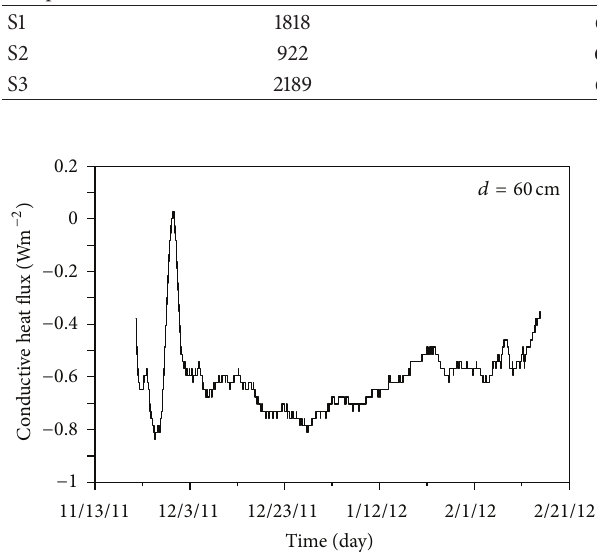
Figure 5: Heat flux estimated by the finite-difference approximation for 60 cm depth.